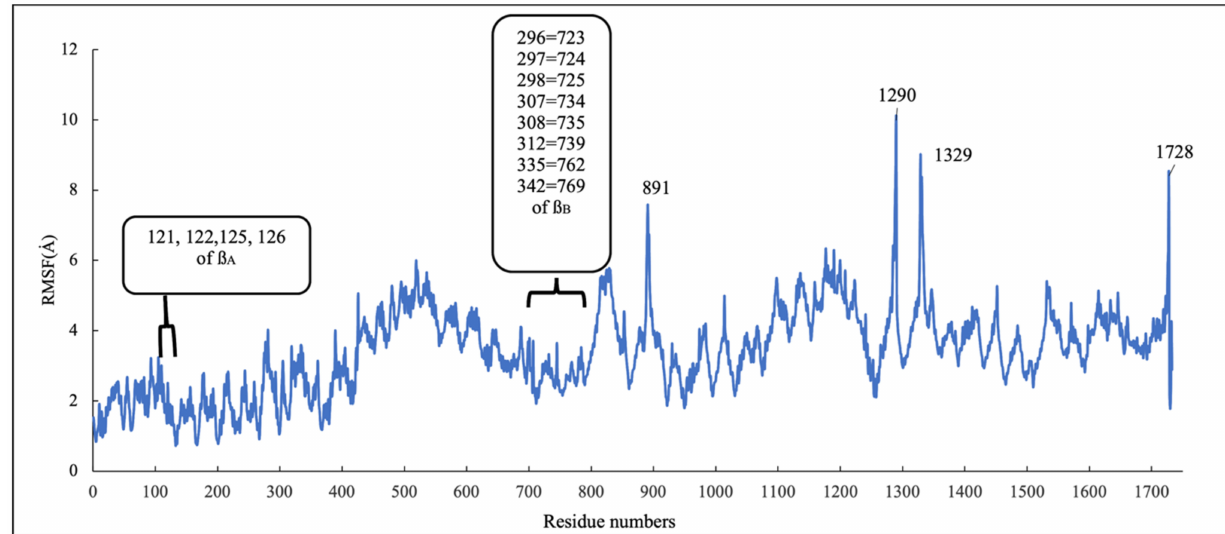
Figure 13. RMSF of all residues and scoulerine in laulimalide binding sites.